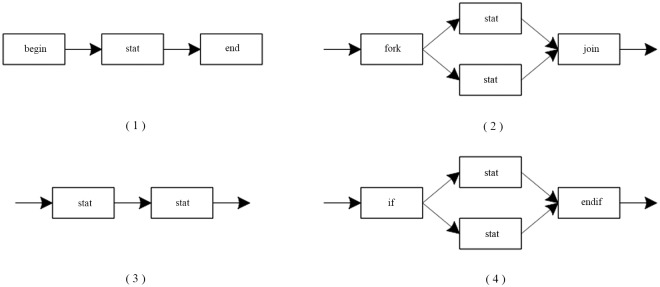
The unions in Fig 8.